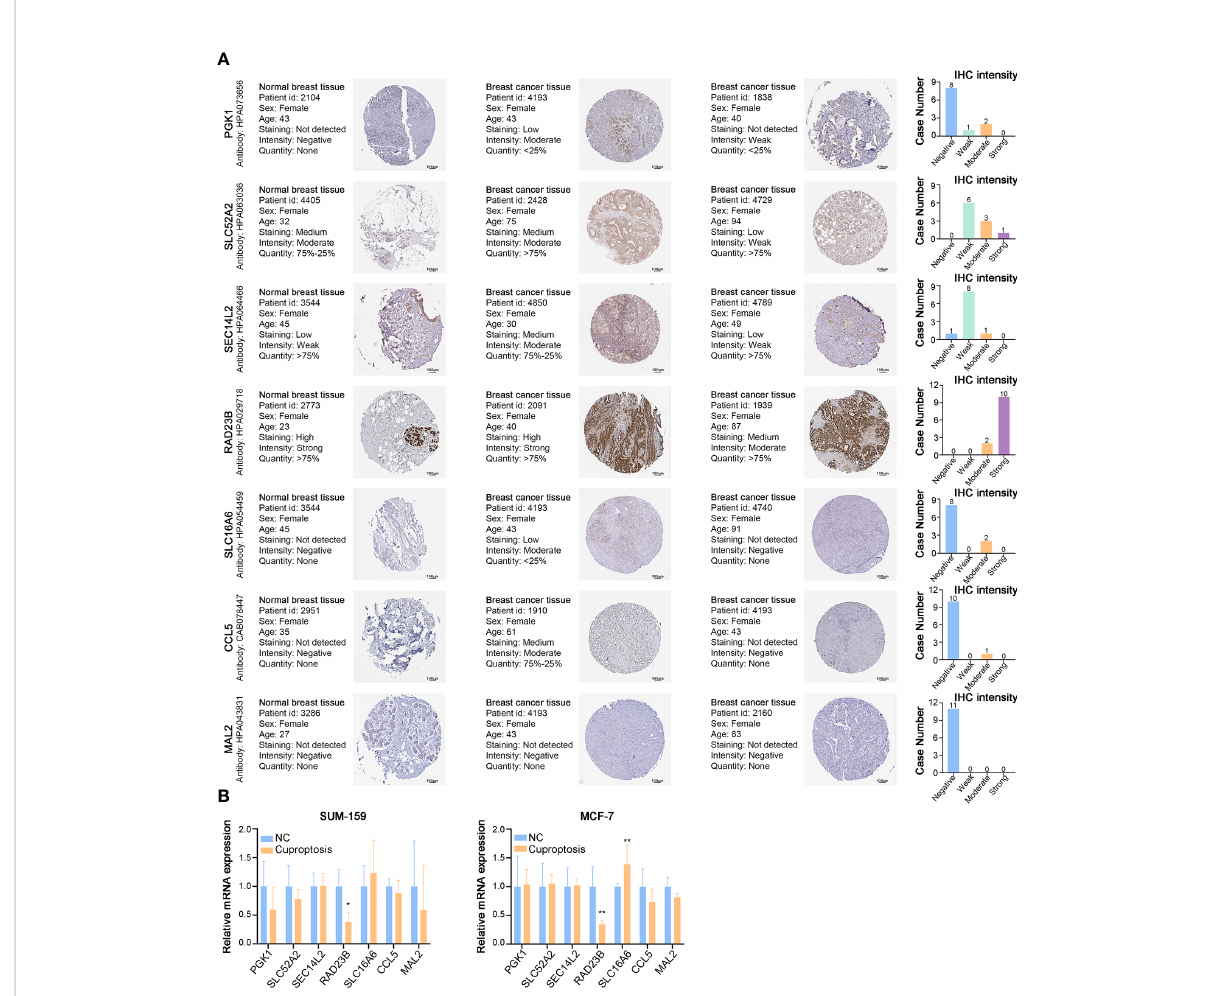
FIGURE 10 Expressions of Cuproptosis-Related Gene Signature in BRCA. (A) Representative IHC images of PGK1, SLC52A2, SEC14L2, RAD23B, SLC16A6, CCL5, and MAL2 across clinical specimens of normal and tumor samples in the Human Protein Atlas (HPA) database. Bar charts represent IHC staining intensities of PGK1 (11 patients), SLC52A2 (10 patients), SEC14L2 (10 patients), RAD23B (12 patients), SLC16A6 (10 patients), CCL5 (11 patients), and MAL2 (11 patients). (B) The relative mRNA expression of PGK1, SLC52A2, SEC14L2, RAD23B, SLC16A6, CCL5, and MAL2 in the cuproptosis cell model (RT-PCR). * p < 0.05, ** p <